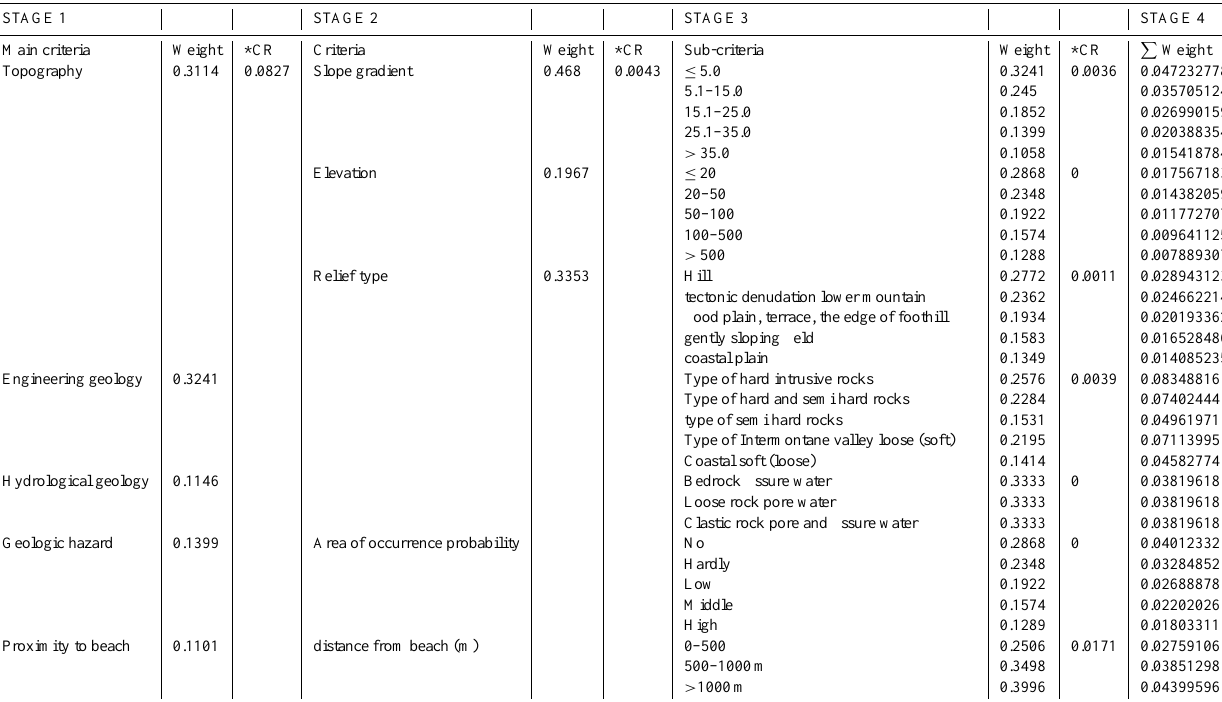
Table 2. Evaluation of five variables and sub-variables with evaluation scores for suitability in the Laoshan